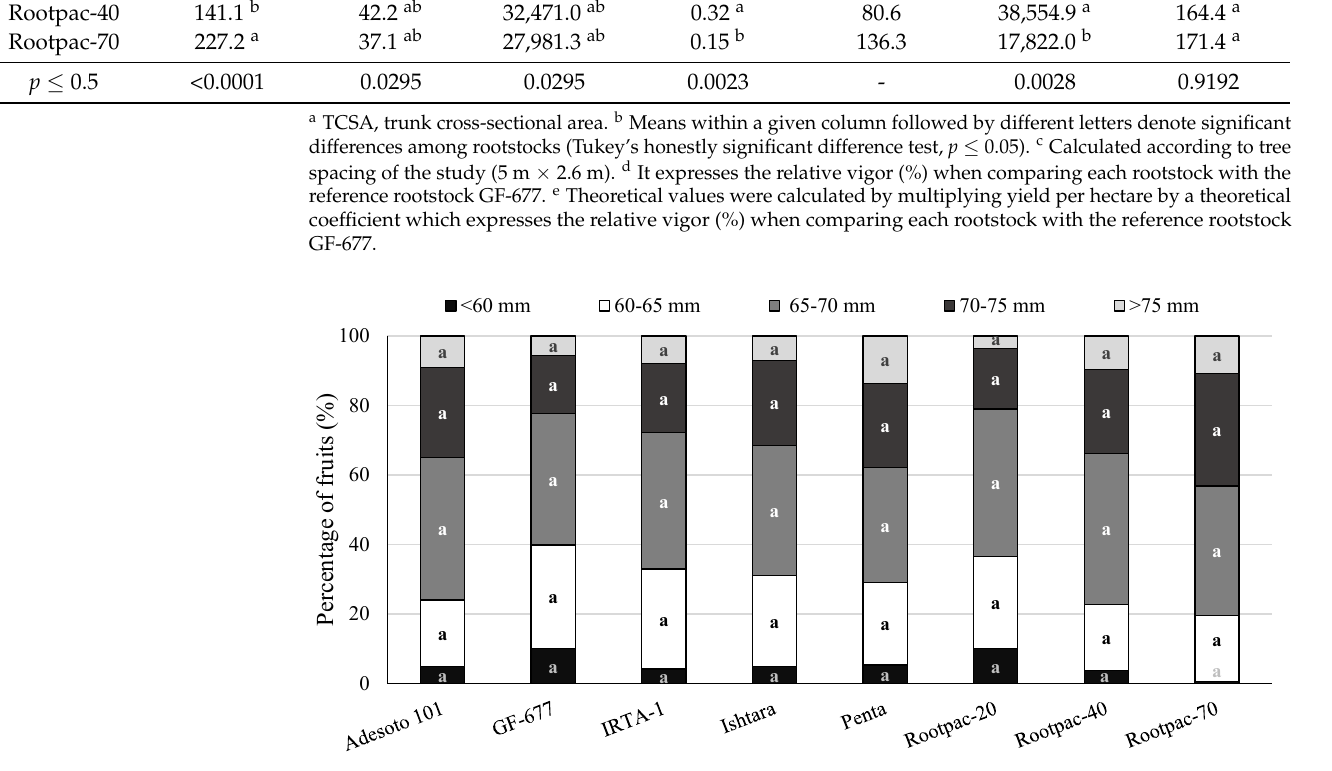
Figure 3. Mean distribution of fruit size for ‘Big Top’ nectarine cultivar grafted onto eight Prunus rootstocks at the IRTA’s Lleida Experimental Station (Gimenells, Lleida) in the tenth crop year (2017). For each distribution, different letters denote significant differences among rootstocks (Tukey’s honestly significant difference test, p ≤